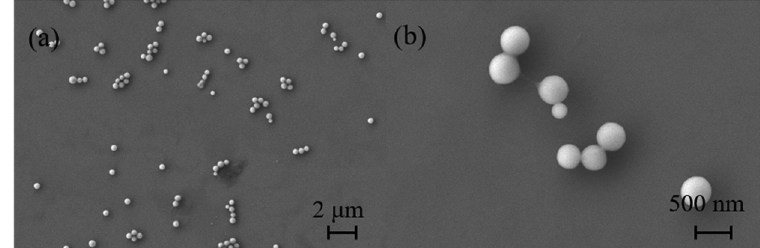
Figure 13: SEM photographs of BSA/AM microcapsules at di ff erent magni fi cations: ( a ) 10 × and ( b ) 50 ×